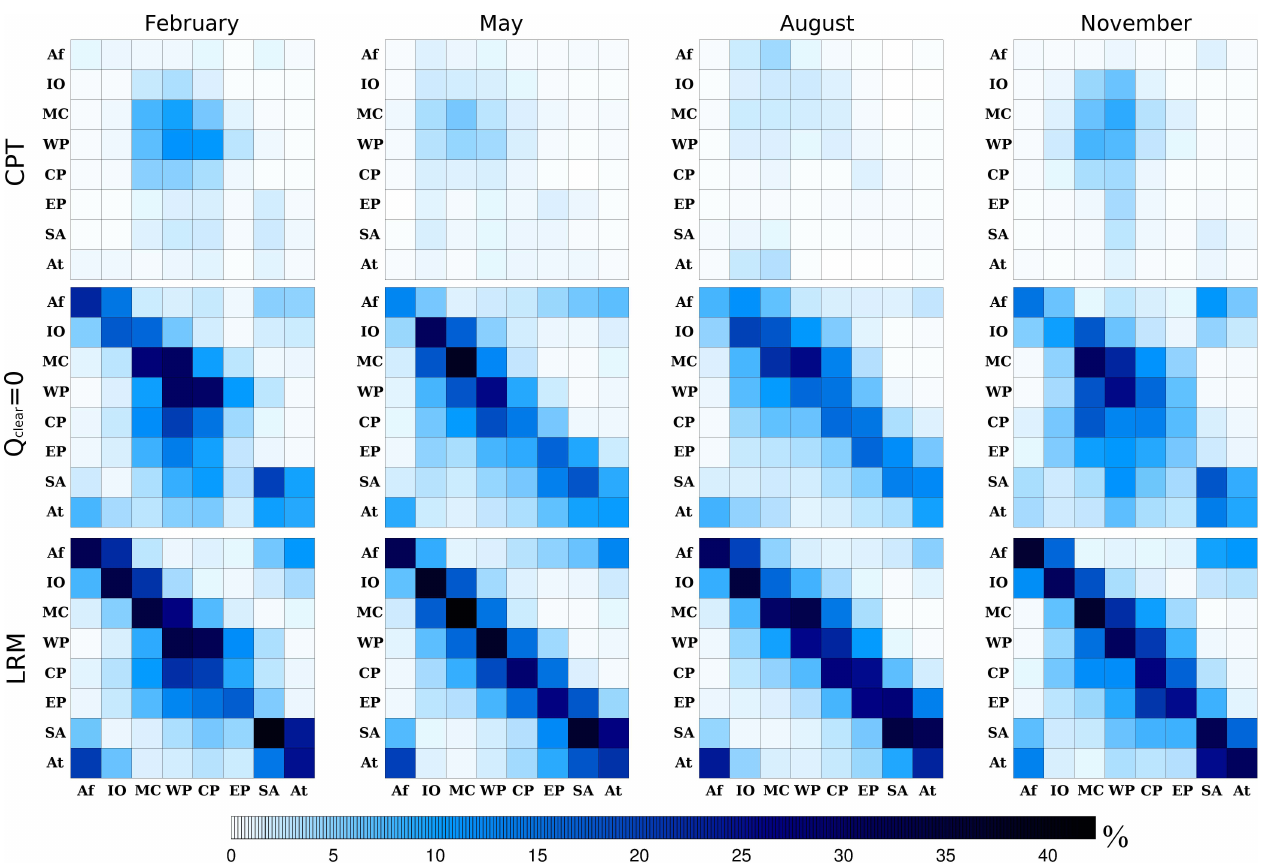
Fig. 4. Matrices that represent tropical transport pathways of 8 regional surface emitted tracers (x-axis) to the same 8 regions (y-axis) for 3 levels in the TTL; LRM, Q clear =0 and the CPT – shown by the 3 rows. Results are shown for the mean over the last 10 days for the February, May, August and November 2005 integrations. Darker colours represent high relative mass mixing ratios (see Fig.